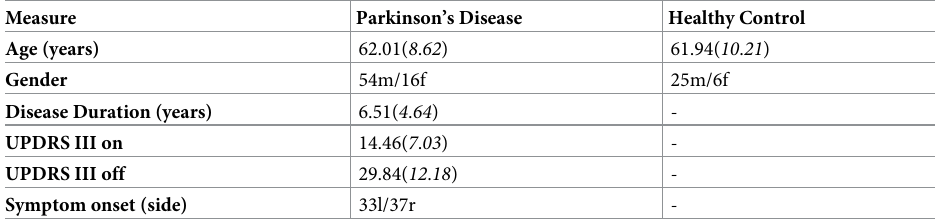
Table 1. Descriptive statistics.